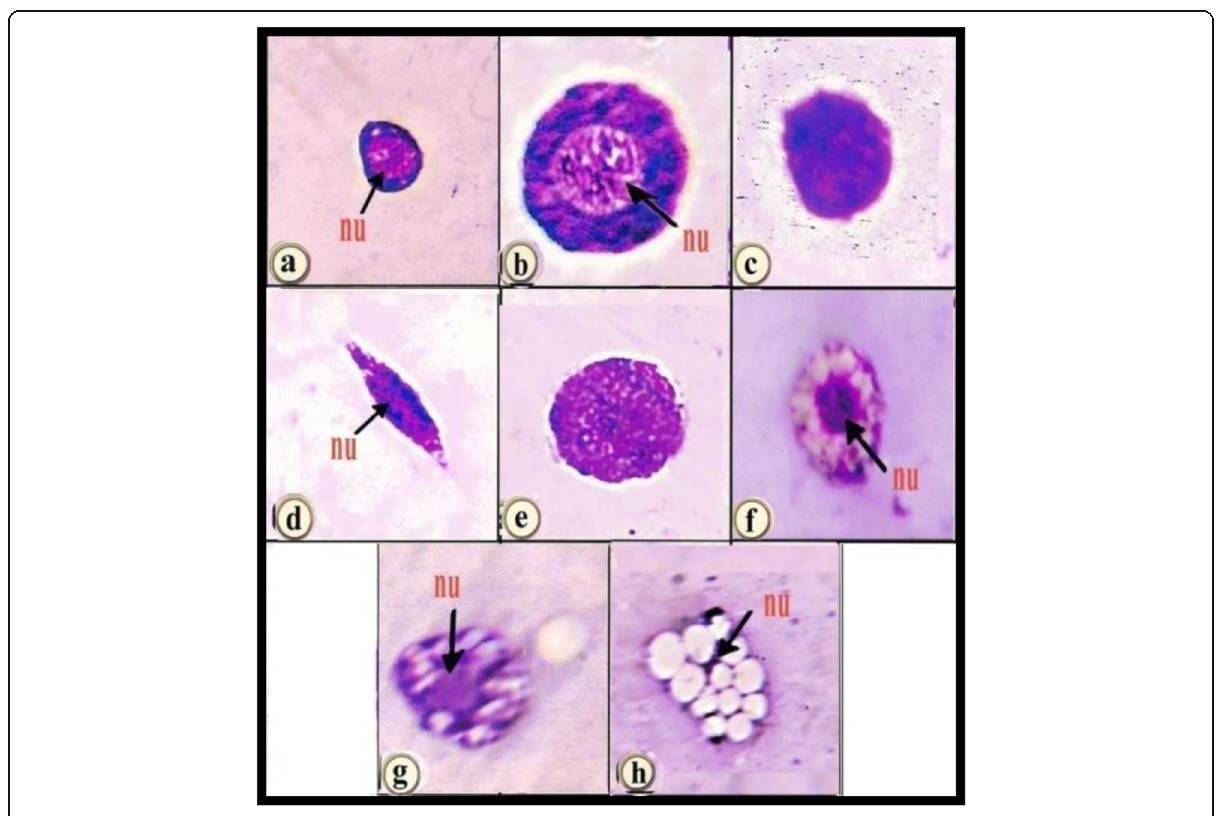
Fig. 1 Normal hemocytes of Galleria mellonella larvae ( x = 1600). a Prohemocytes, b plasmatocytes, c granulated cells, d spindle cells, e spherule cells, f adipohemocytes, g oenocytoids, h cystocytes. nu indicates the hemocyte